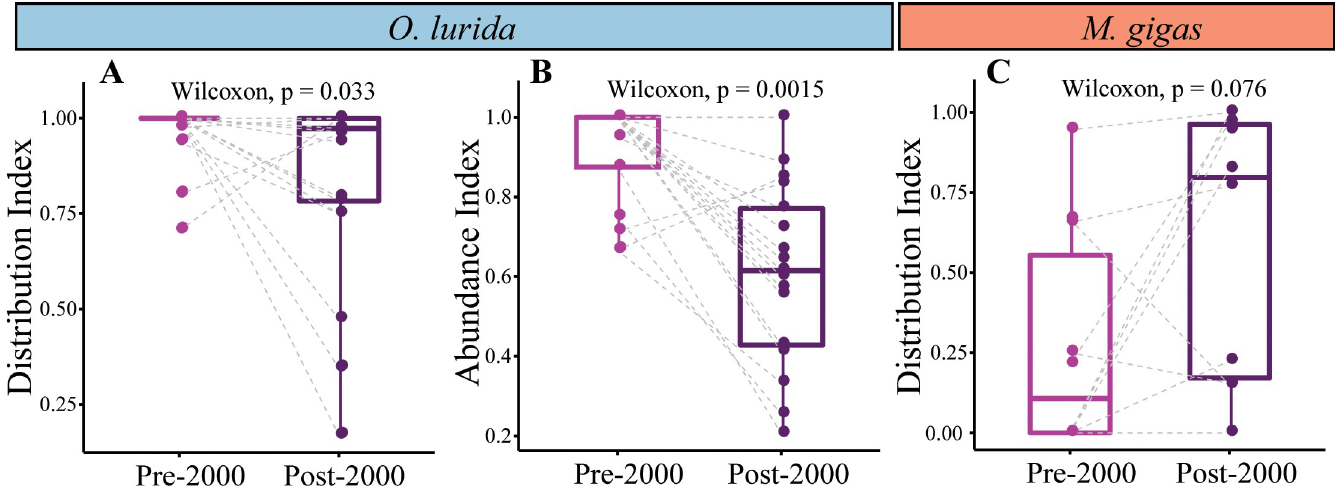
Fig 7. Paired comparisons of distribution and abundance indices in the same estuary over time. (A) O . lurida distribution index (n = 21 estuaries). (B) O . lurida abundance index (n = 17). (C) M . gigas distribution index (n = 10). A dashed line connects the same estuary pre-2000 vs. post-2000.